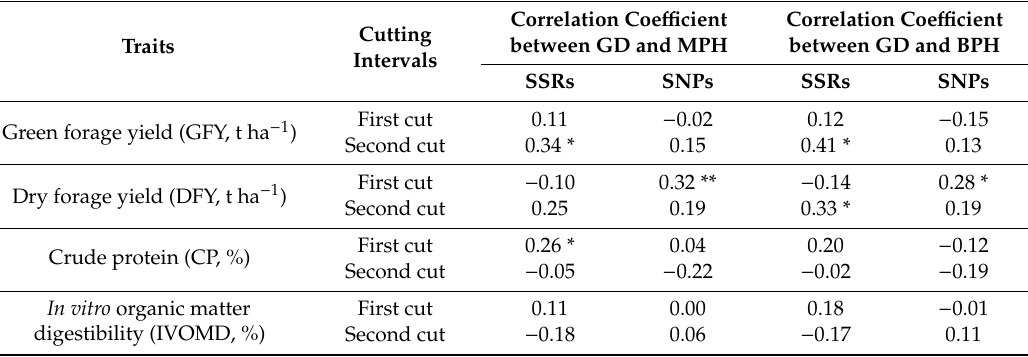
Table 6. Correlation between genetic distance (GD) between parents measured using SSRs and SNPs and heterosis (Mid-parent heterosis (MPH) and Better-parent heterosis (BPH)) for forage yield and quality traits in pearl